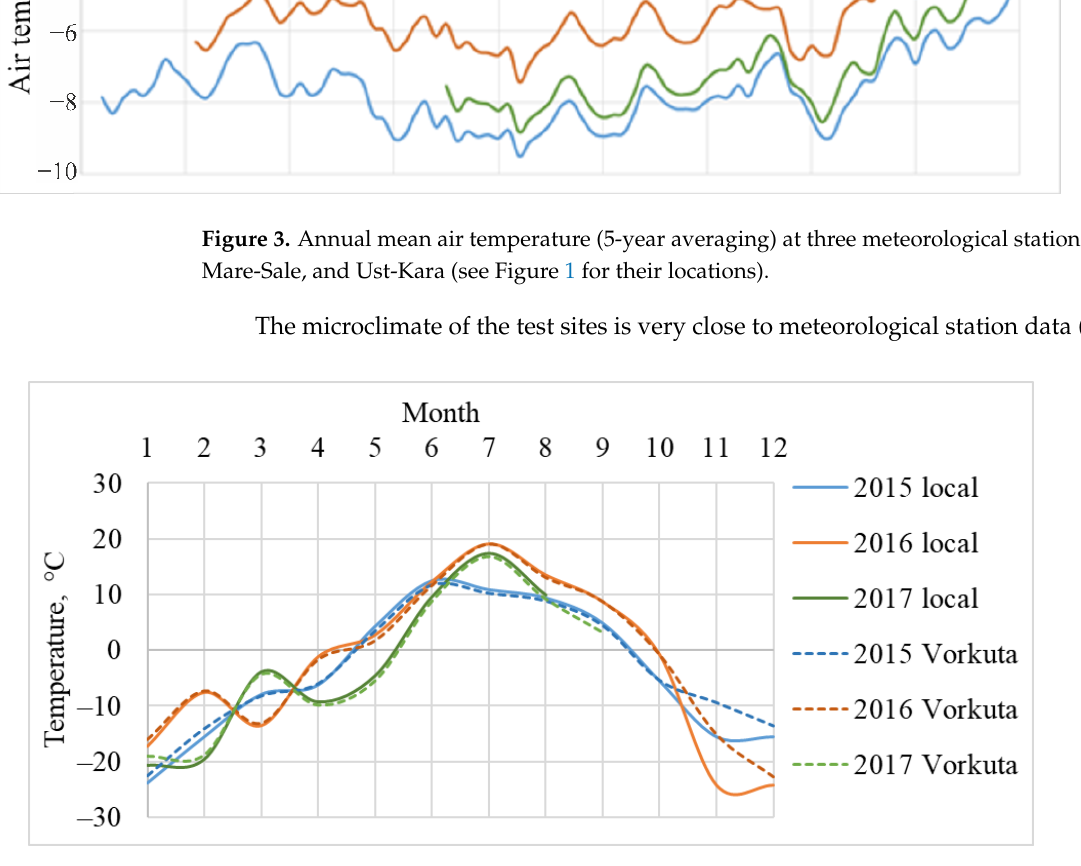
Figure 4. Comparison of the variation of mean monthly air temperatures according to the data of Vorkuta weather station and microclimatic observations at the Khanovey test site.